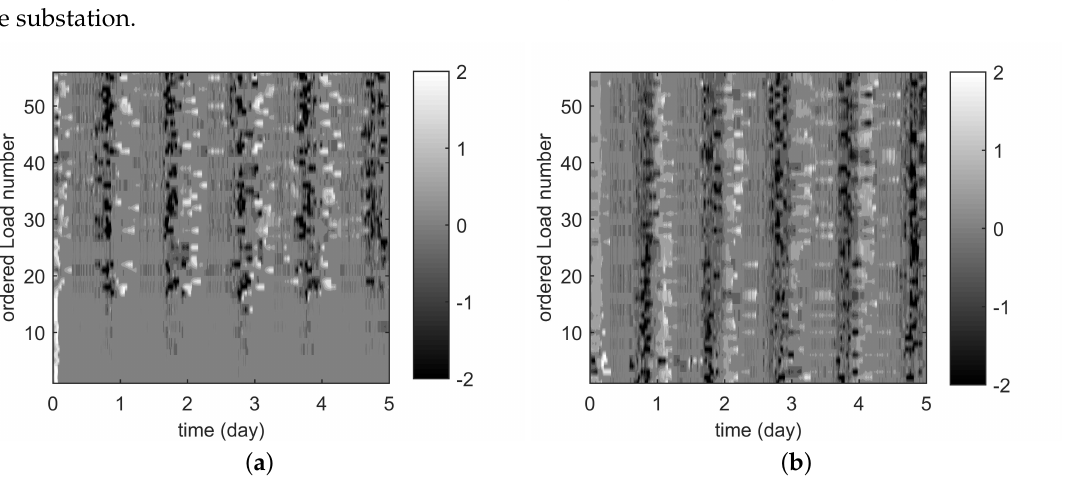
= 3.89 and ζ ∗∗∗ = 2.54. ( a ) Battery cycling for each load; D C